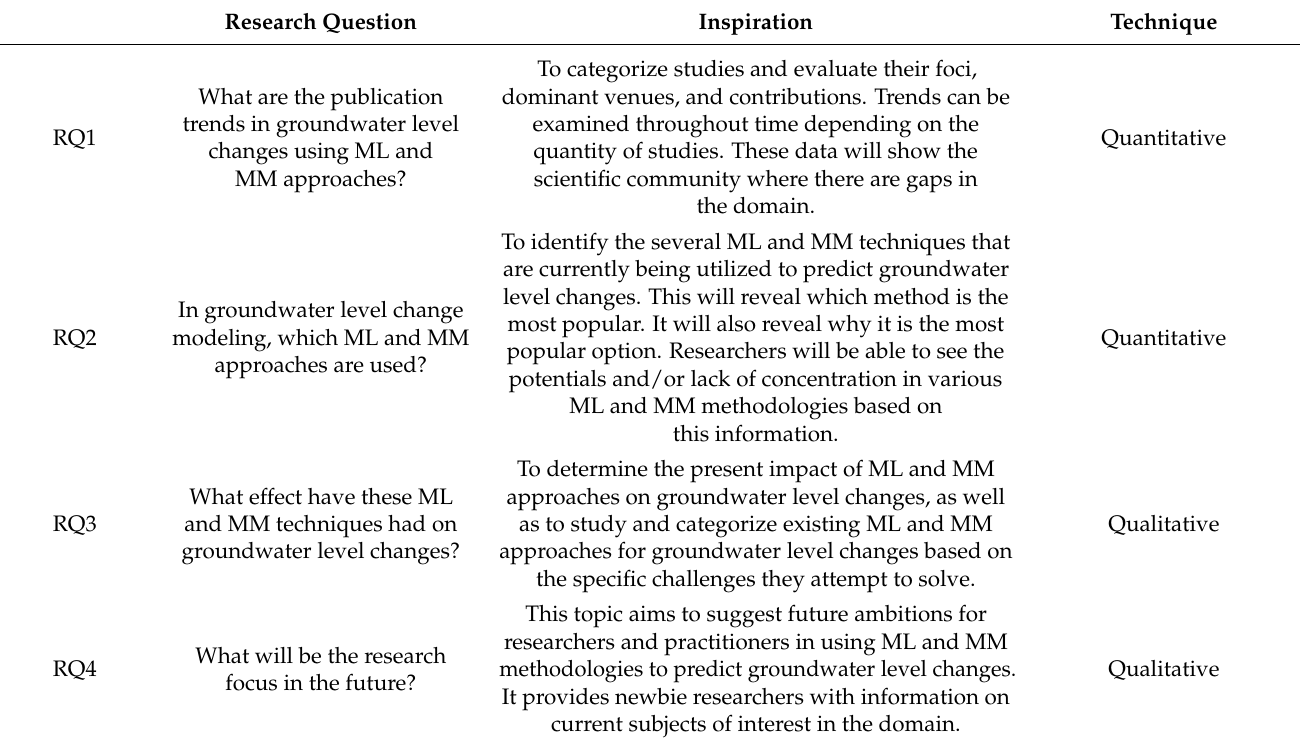
Table 3. Review interrogations and